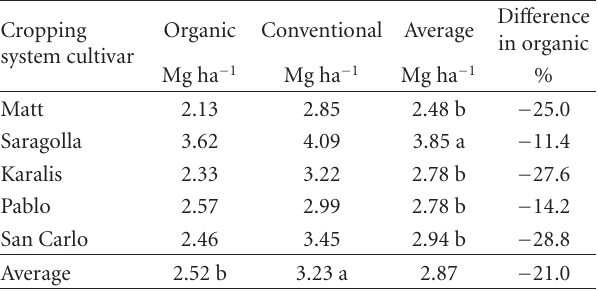
Table 2: Grain yield: e ff ect of cropping system and cultivar. Cropping system